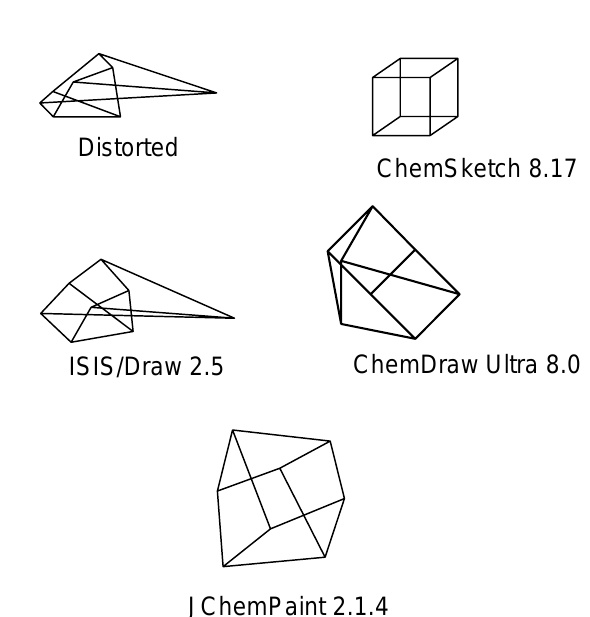
Figure 1. The result of Clean Structure command execution in popular structure